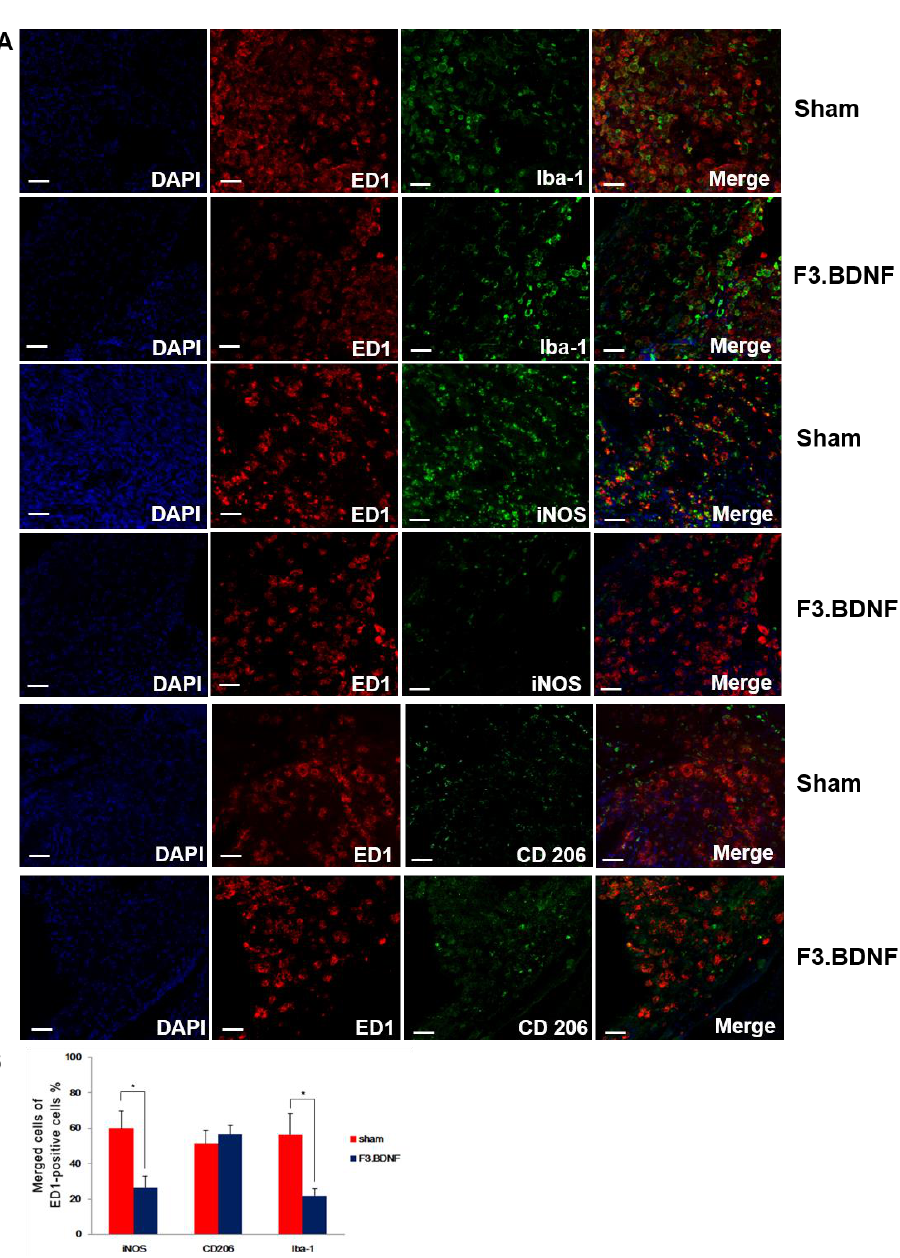
Figure 5. Histological analysis of inflammation. ( A ) Immunofluorescence staining showing differ- ences in the expression of microglia marker Iba-1, in which M1 phenotype for classically activated macrophages (iNOS) and M2 phenotype for alternatively-activated macrophages (CD 206) were co- localized with ED1 (red) at 10 weeks after F3.BDNF transplantation in the injured spinal cord. In the F3.BDNF group, the number of iNOS-positive cells was decreased, and the number of CD206-posi- tive cells was increased compared to those of the sham group. The nuclei were counterstained with DAPI (blue). ( B ) Percentage of merged cells of ED1 -positive cells around the epicenter region (scale bars = 20 μm; * p < 0.05).